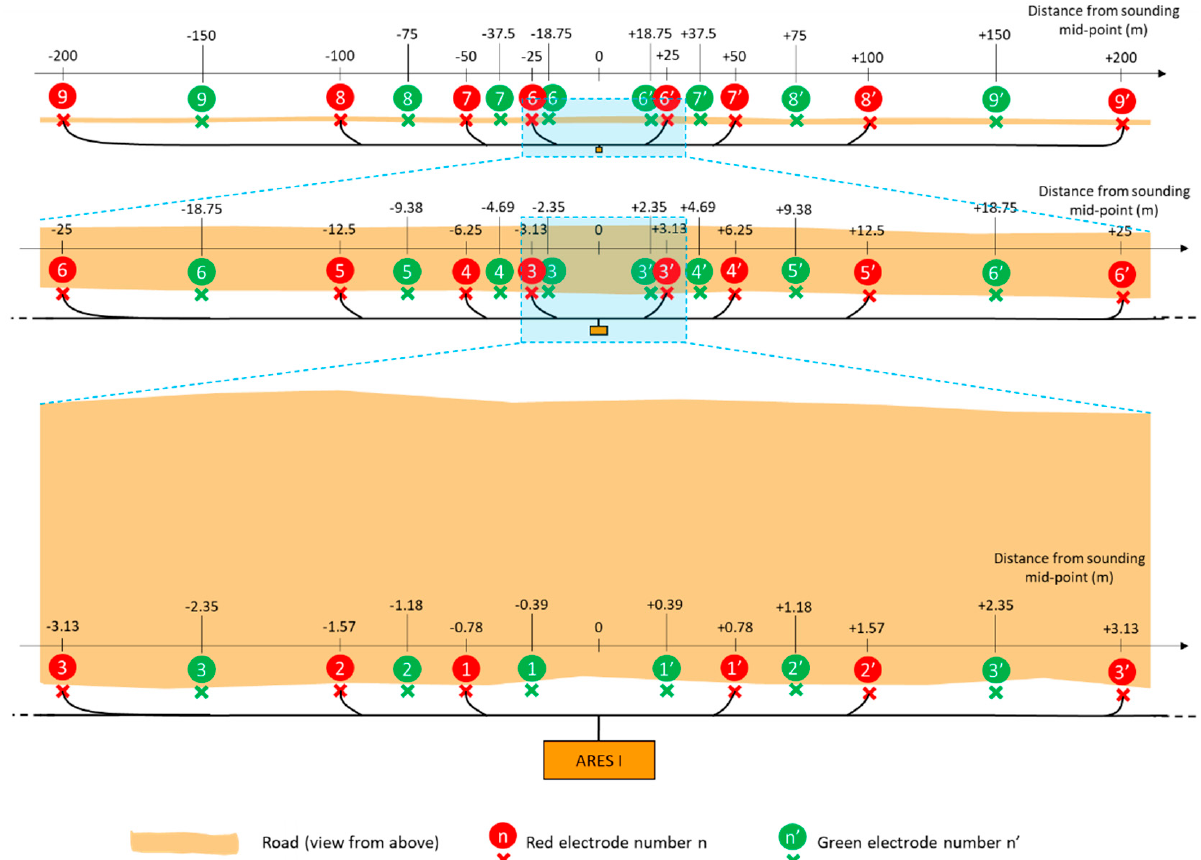
Figure 4. Electrode/cable layout designed for the individual vertical electrical soundings (VESs).